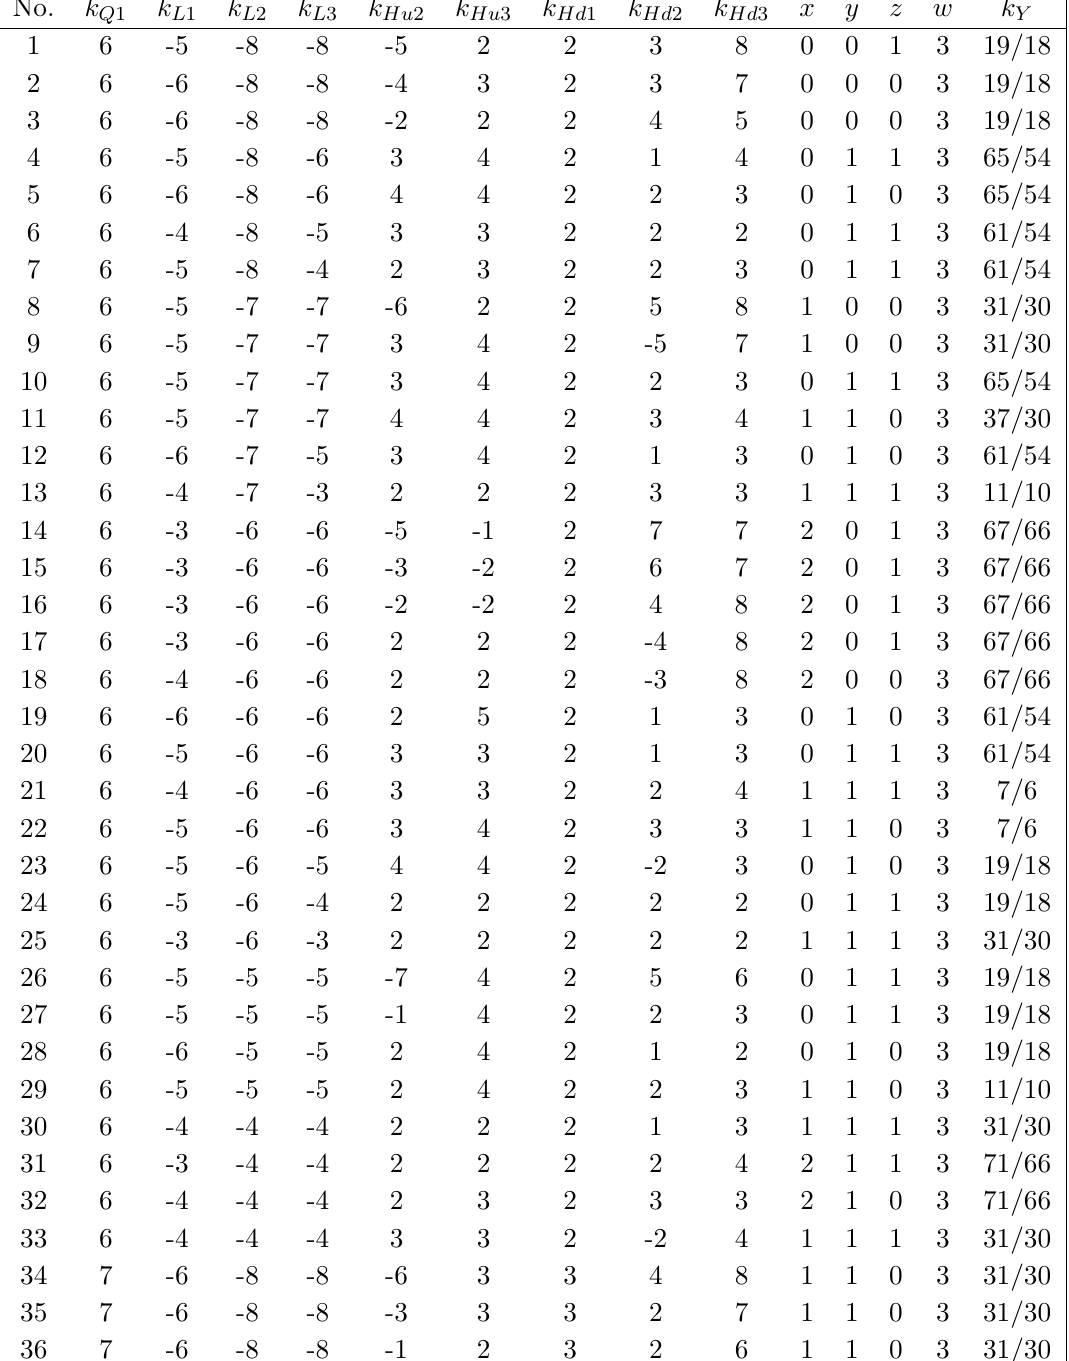
Table 7 . The parameters of the charge assignment ( N h =